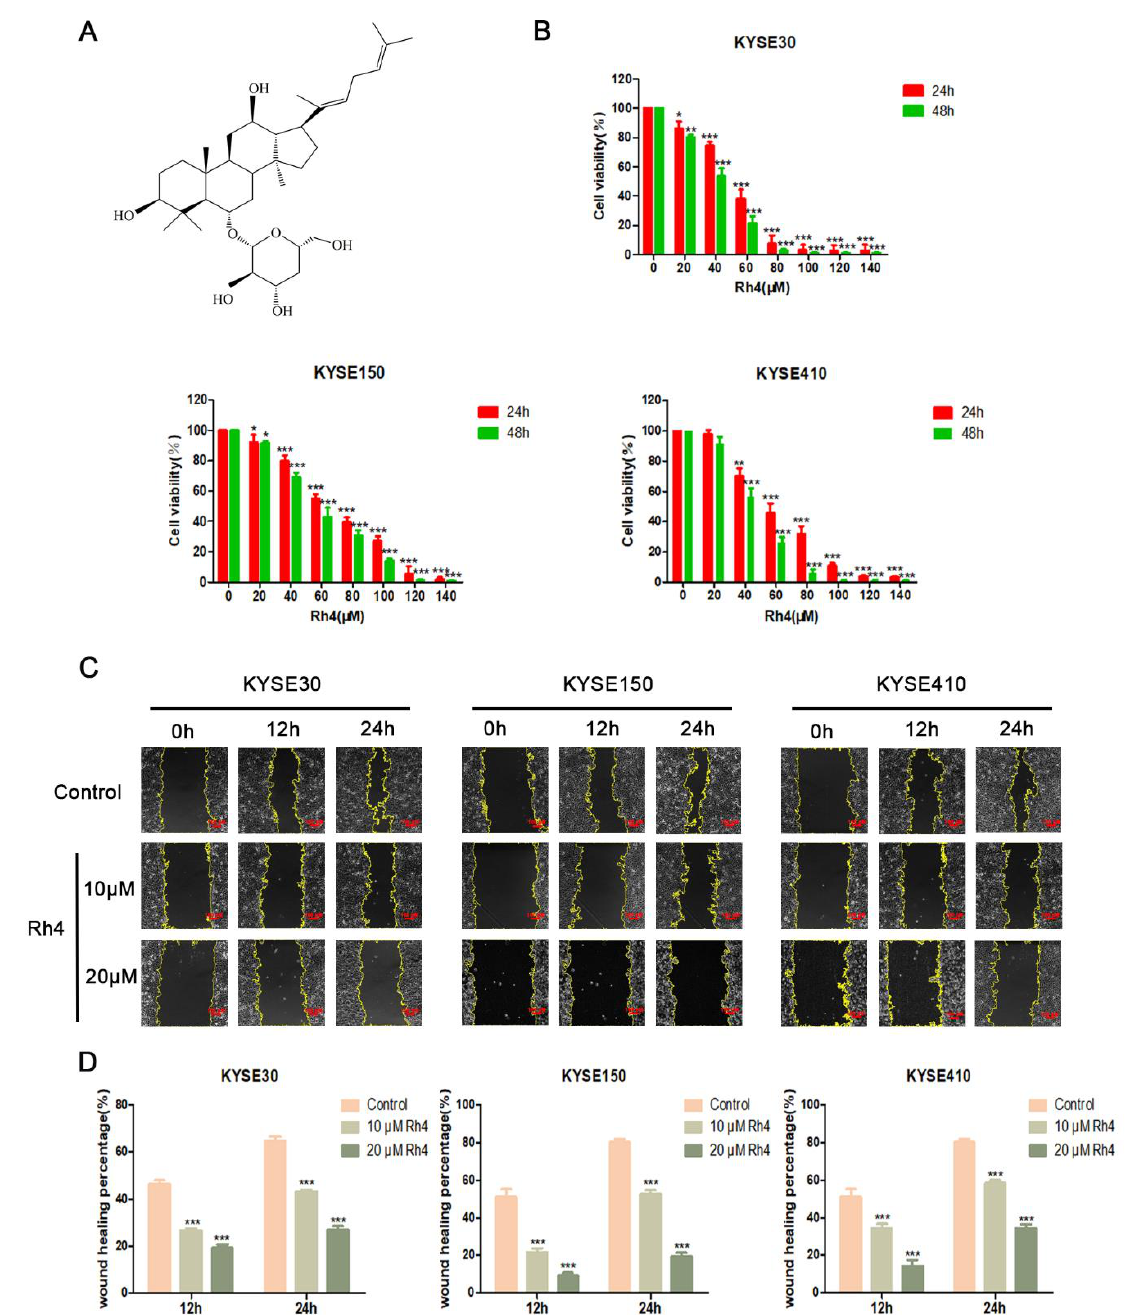
Figure 1. ( A )The chemical structure of ginsenoside Rh4. ( B ) KYSE30, KYSE150, and KYSE410 were measured with designated content (0 – 140 µM) of Rh4 cell viability ( C ) Migration images of Rh4 cells with or without the addition of Rh4 cells at 0, 12, and 24 h. The yellow line is the migration edge. Scale bar = 100 µm ( D ) Percent wound healing, treatment group vs. control group. All data are presented as mean ± SD, * p < 0.05, ** p < 0.01, and *** p < 0.001.